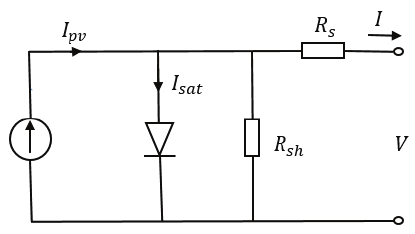
Figure 1. Equivalent circuit of single-diode model (SDM) for photovoltaic (PV)